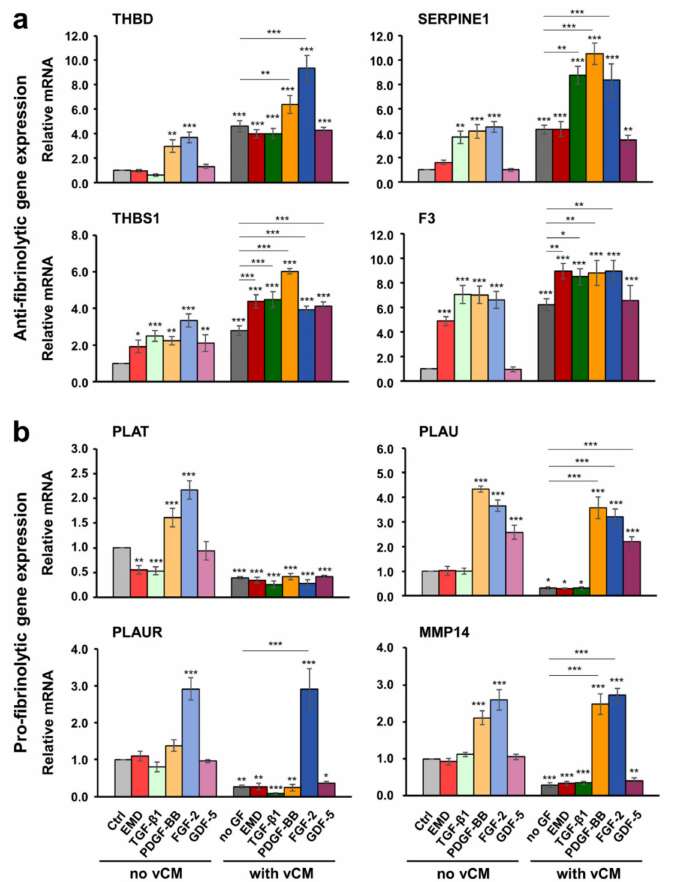
Figure 4. Effect of native/uncoated or growth factor-coated vCM on the anti- ( a ) and pro- fibrinolytic ( b ) gene expression in primary hPDLCs. Cells were grown under each of the four experimental conditions described in Figure 3 before total RNA was extracted and analyzed by qRT-PCR for the expression of THBD, SERPINE1, THBS1, and F3 antifibrinolytic ( a ) as well as PLAT, PLAU, PLAUR, and MMP14 profibrinolytic ( b ) genes. Values normalized to the housekeeping GAPDH are expressed relative to the values of control cells (Ctrl) grown as described in Figure 3a. Means ± SD from three independent experiments and significant differences to the Ctrl unless otherwise indicated, *** p < 0.001, ** p < 0.01, * p < 0.05 are